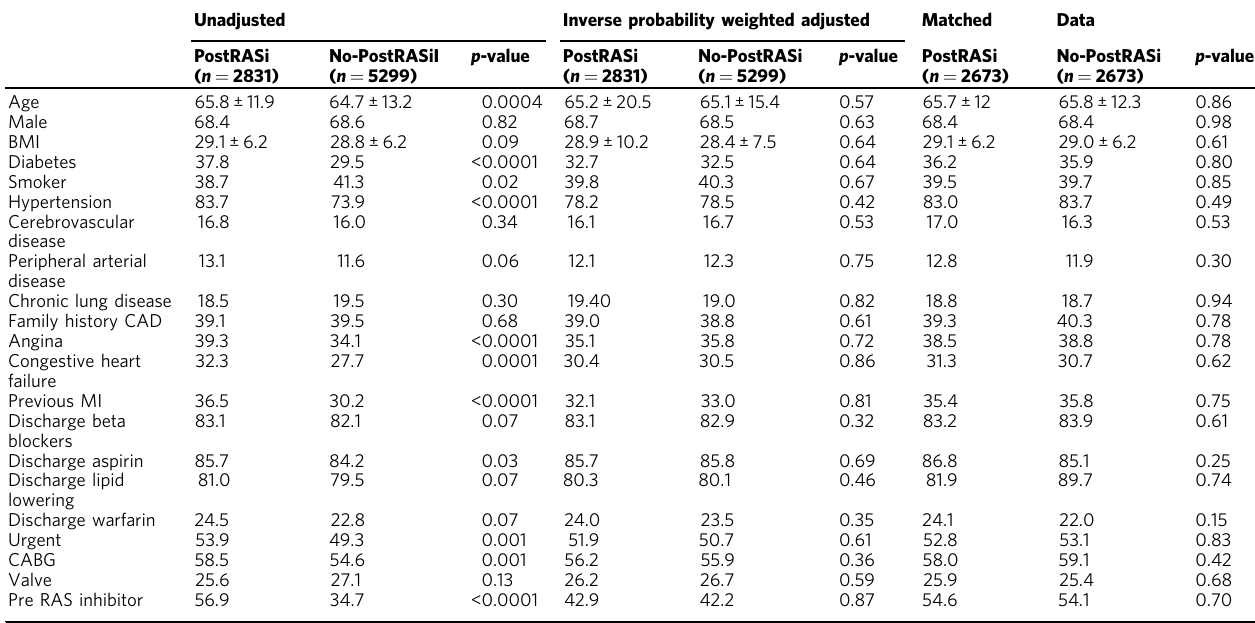
Table 2 Demographic and Clinical Characteristics: Post RAS Inhibitors Unadjusted Inverse probability weighted adjusted